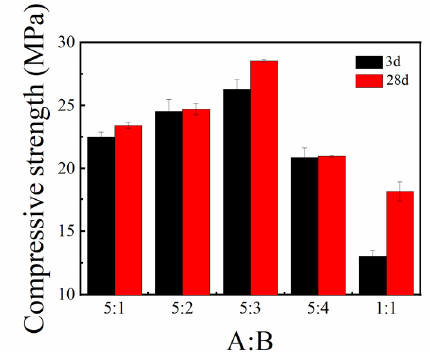
Figure 9. Effect of the ratio of A to B on the compressive strengths of the cement stone at the ages of 3 d and 28 d.